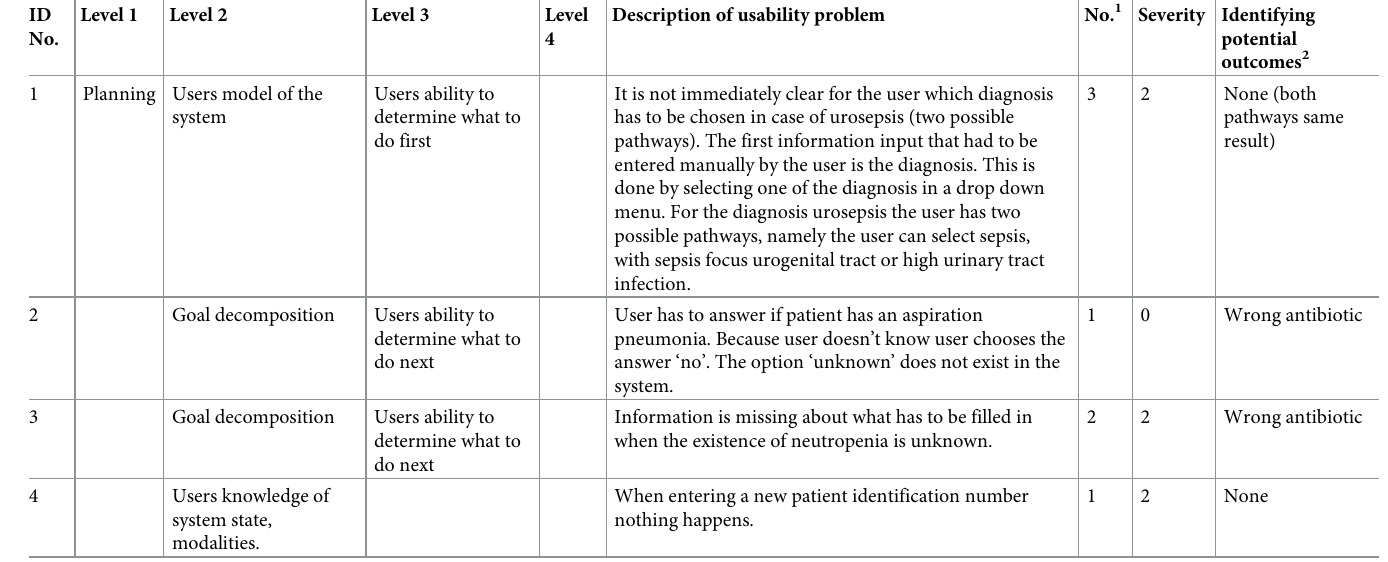
Table 1. Usability problems in the UAF planning phase with their severity and potential effect on task